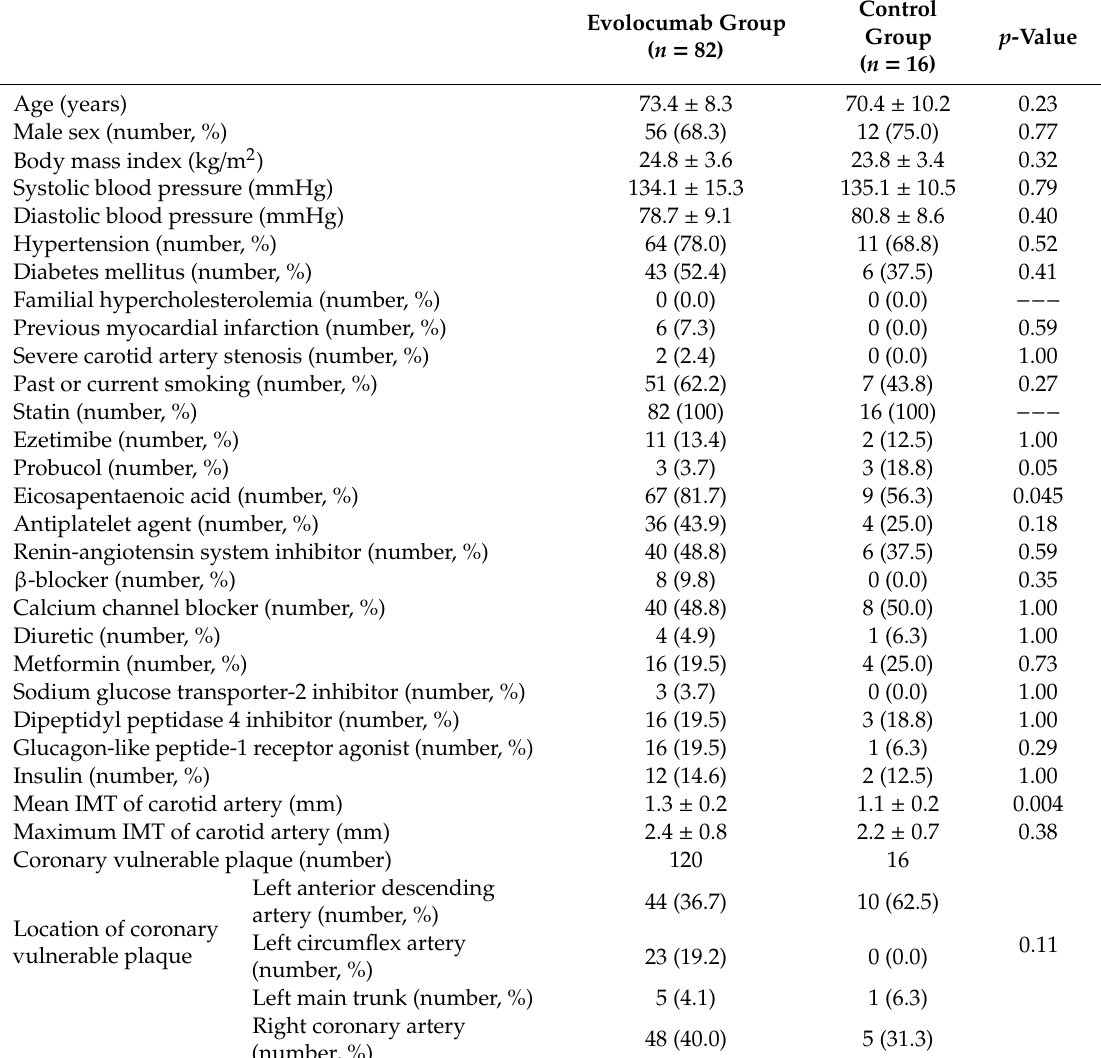
Table 1. Participant characteristics and medications at